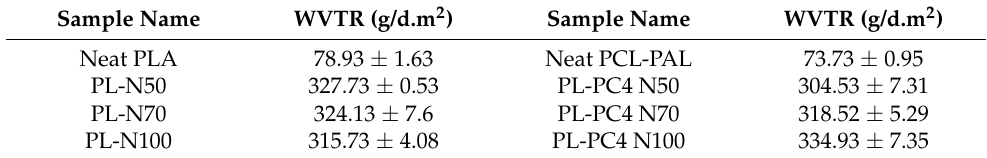
Table 6. Water vapor transmission rate (WVTR) of neat PLA and porous PLA and PCL/PLA films.